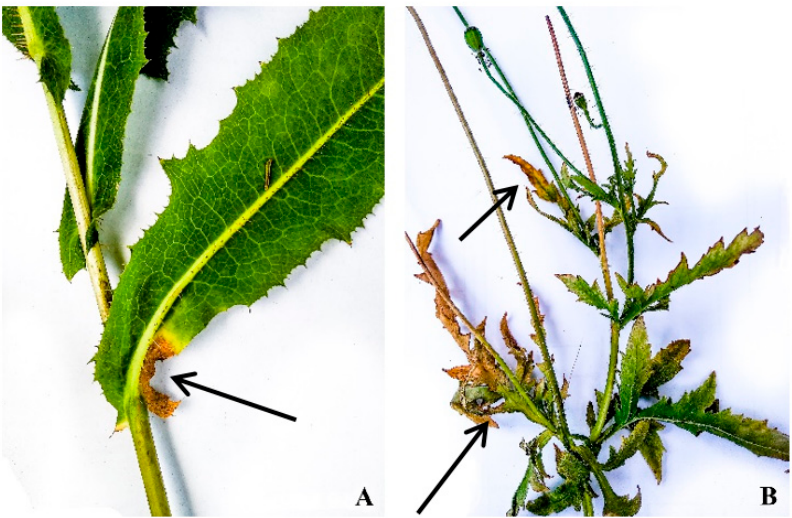
Figure 1. Symptoms on of Sonchus arvensis L. ( A ) and Papaver argemone L. ( B ) found in wheat fields.